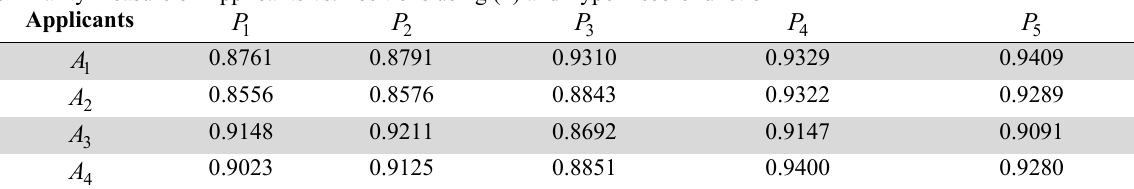
Similarity measure of Applicants vs. Positions using (4) and Type-1 score